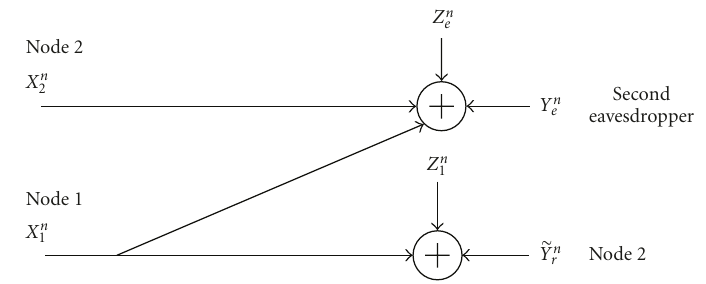
Figure 5: Channel model after